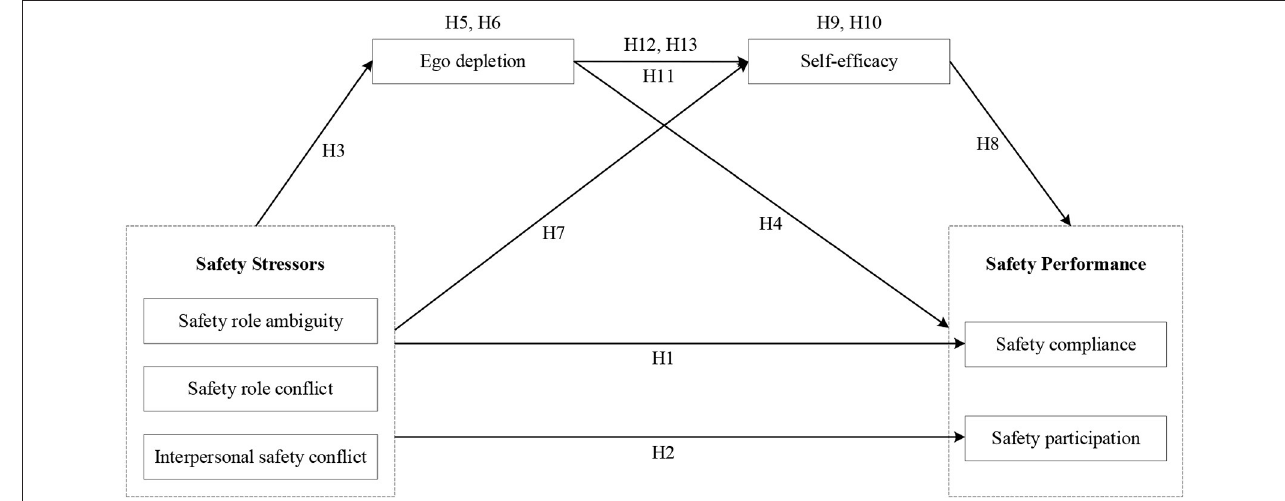
FIGURE 1 | The conceptual model.